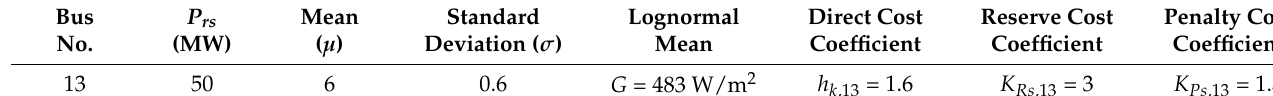
Figure 3. Wind speed distribution at bus #11.